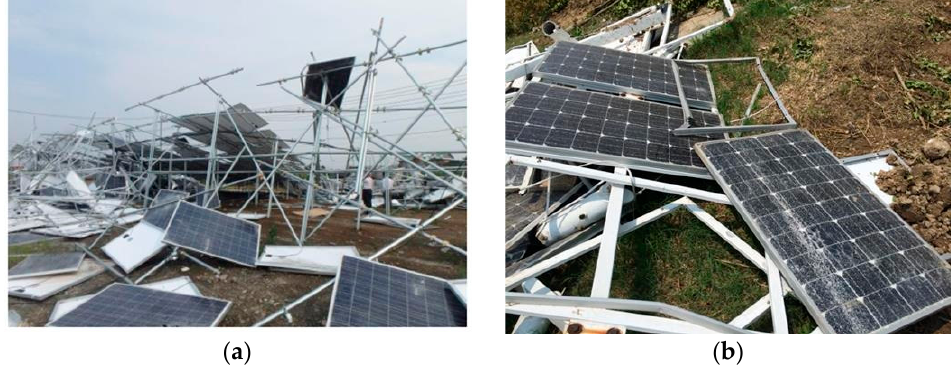
Figure 3. Example of wind-induced damages on PV panel arrays: ( a ) In Iseisaki city, Gunma prefecture, Japan in 2015; ( b ) In Yancheng city, Jiangsu province, China in 2015.